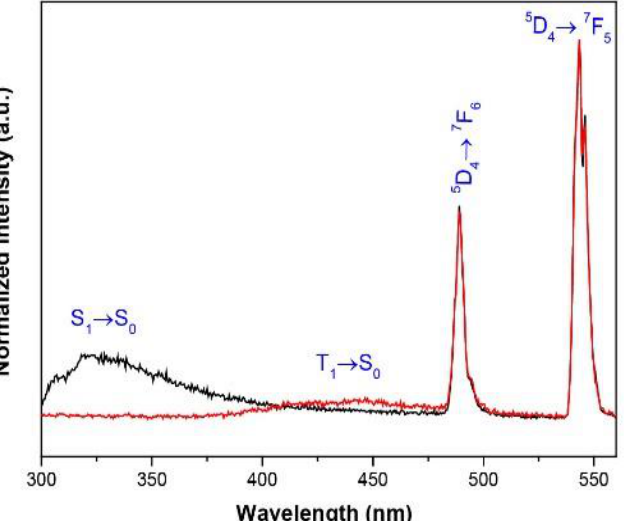
Figure 9. Time-resolved emission spectra of 1 @PMMA recorded at 12 K measured with 290 nm excitation. Black line: initial delay of 0.01 ms and integration time of 0.1 ms; red line: initial delay of 0.05 ms and integration time of 5 ms. Time-resolved emission spectra were not corrected for detection and optical spectral response of the spectrofluorometer.